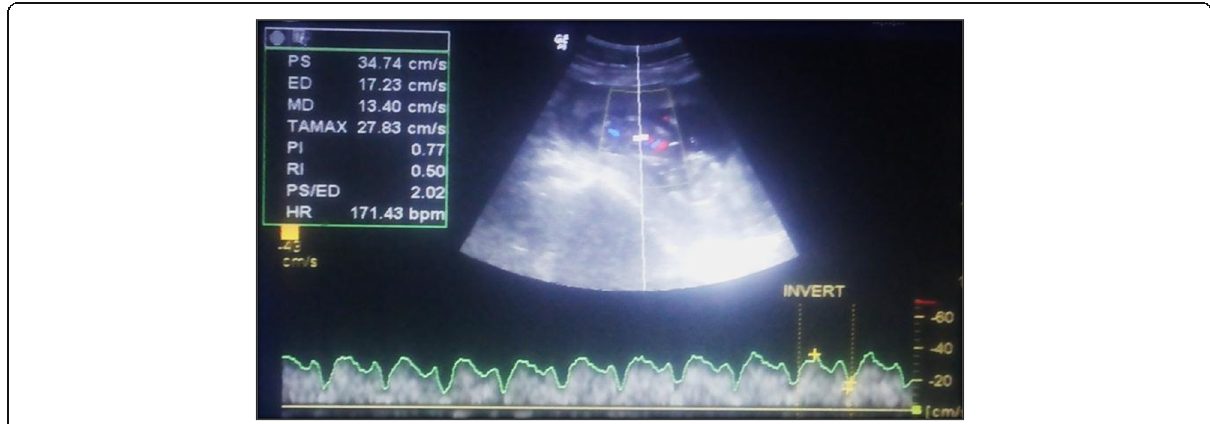
Fig. 1 A triplex image showing the DV measurement of a 22 weeks ’ fetus in sagittal view with the normal Doppler